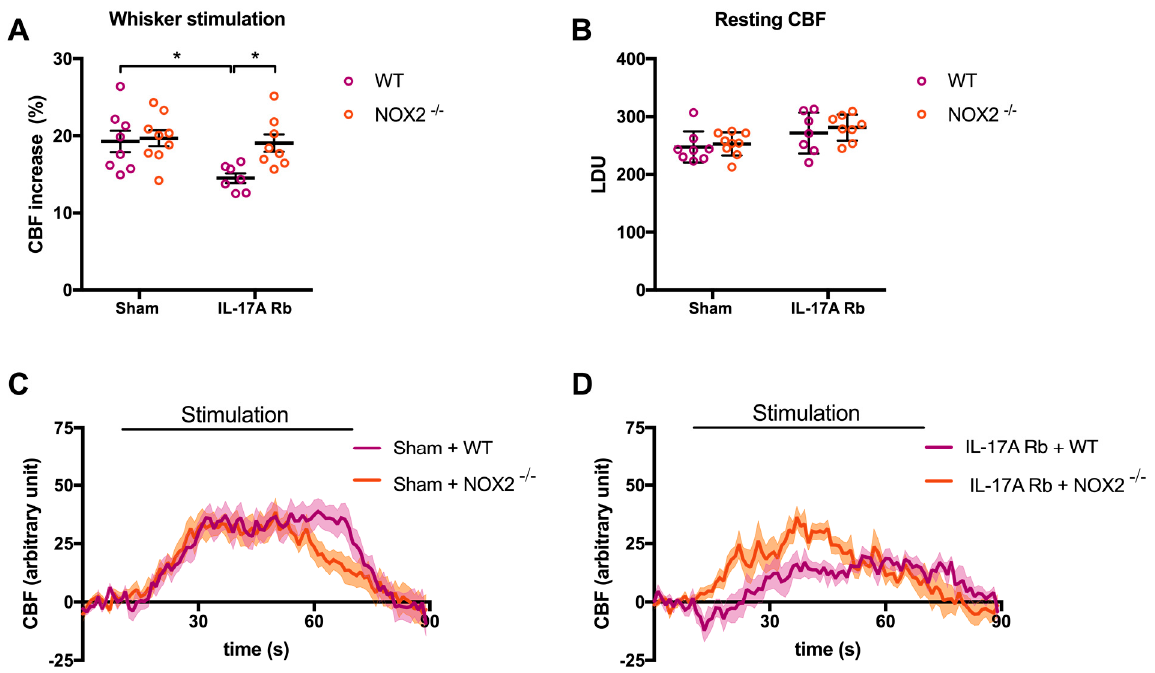
Figure 8. NOX2 deletion prevents IL-17A-induced neurovascular coupling impairment. CBF in response to whiskers stimulations measured in vivo by laser Doppler flowmetry in C57BL/6 WT or NOX2 -/- male mice receiving IL-17A Rb through an osmotic minipump (50 pg/kg/h, 7 days). The graphs depict ( A ) CBF as percentage changes with respect to the initial CBF value, ( B ) resting CBF value as LDU, and ( C , D ) 1 second average curves of the evoked CBF, expressed in arbitrary unit. SEM is represented by the lighter tone shade surrounding each curve. Data were analyzed using an ANOVA for factorial design followed by a Bonferroni post-test. * p < 0.05; n = 7–9 per group. 3. Discussion We tested the hypothesis of whether IL-17A mediates the NVC impairment induced by Ang II through NOX2-derived ROS. The major new findings of this study are that neu- tralizing IL-17A or its receptor prevents Ang II-induced ROS production and NVC im- pairment. This was supported by showing ROS increase and NVC impairment following chronic IL-17A administration. A ROS scavenger and NOX2 deletion prevented these ef- fects suggesting that NOX2-derived ROS production is responsible for the NVC impair- ment induced by this cytokine. Ang II through the Ang II type 1 receptor (AT1R) signaling pathway is an important pro-inflammatory stimulus, triggering the production of cerebral and systemic pro-in- flammatory cytokines [4,17–19], chemokines [20] and ROS [5,11,21–24]. A putative role of inflammation in the effect of Ang II on NVC emerged in a study showing that the adaptive transfer of Treg lymphocytes (CD4+/CD25+) or of IL-10 prevents NVC impairment. In that study, Ang II administration increased the production of circulating pro-inflammatory cytokines such as IL-1 α , IL-6, IL-17A, TNF- α , and LIF [4]. Inversely, a systemic inflammatory state in mice characterized by higher circulating IL-17A levels and induced by a high-salt diet contributed to NVC impairment [15]. In the present study, neutralizing IL-17A or inhibiting its receptor prevented the NVC impair- ment observed in an Ang II slow pressor hypertension model. Overall, these results sug- gest an important contribution of IL-17A in NVC impairment in models of hypertension. A lower increase in blood pressure induced by Ang II was observed in mice receiving IL-17A Ab or IL-17RA mAB [14] or in IL-17 -/- mice [11]. Our results confirmed the lower rise in blood pressure in mice receiving these Ab treatments. However, these slight changes in blood pressure most probably do not explain the NVC impairment induced by